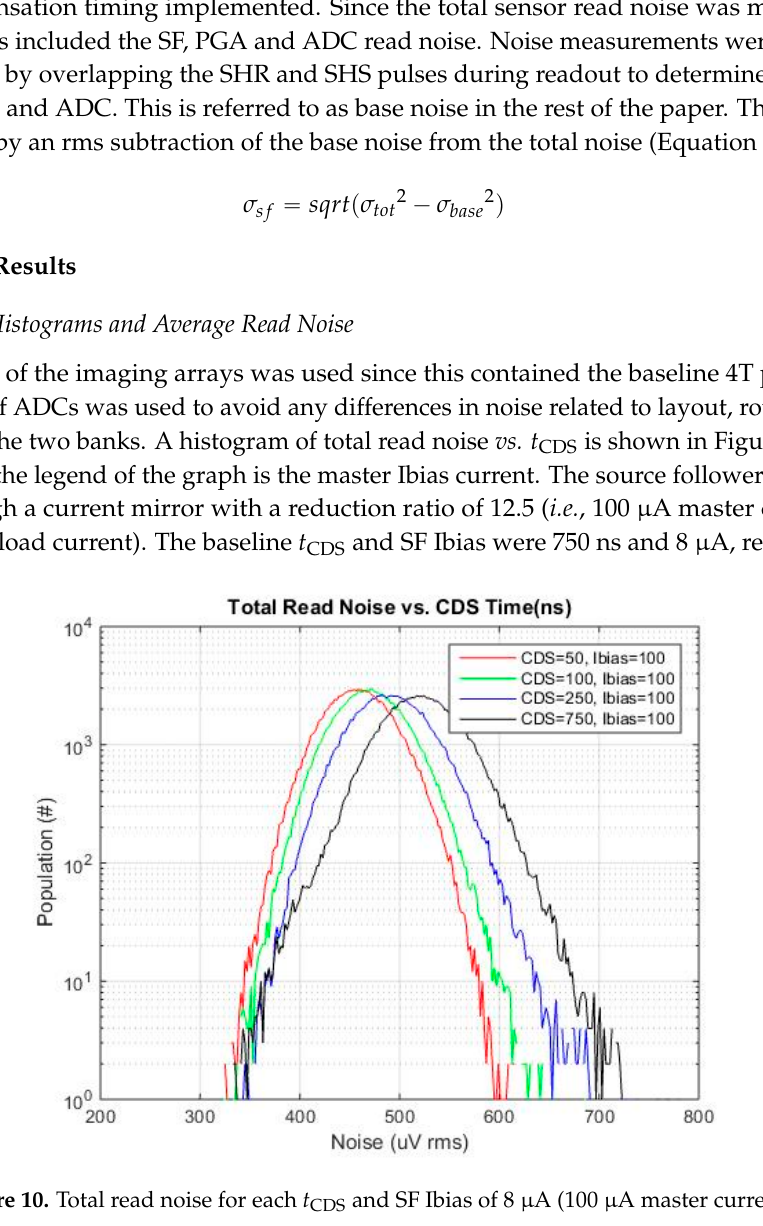
µ A (100 µ A master CDS and SF Ibias of 8